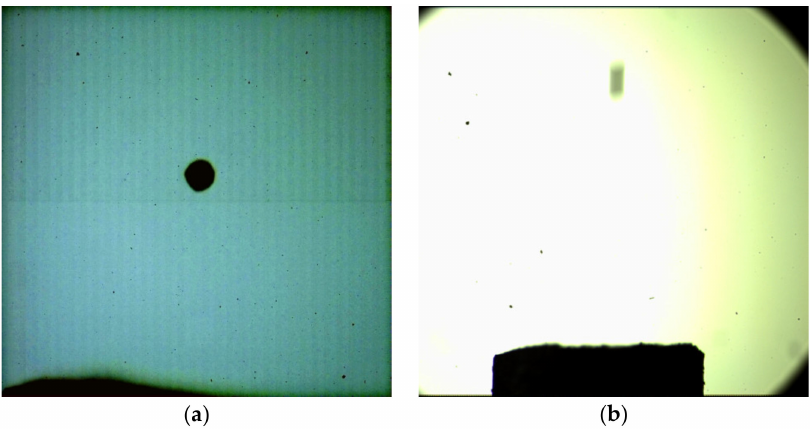
Figure 7. Images of aluminum particle under different exposure time: ( a ) picture taken by camera A; ( b ) picture taken by camera B.